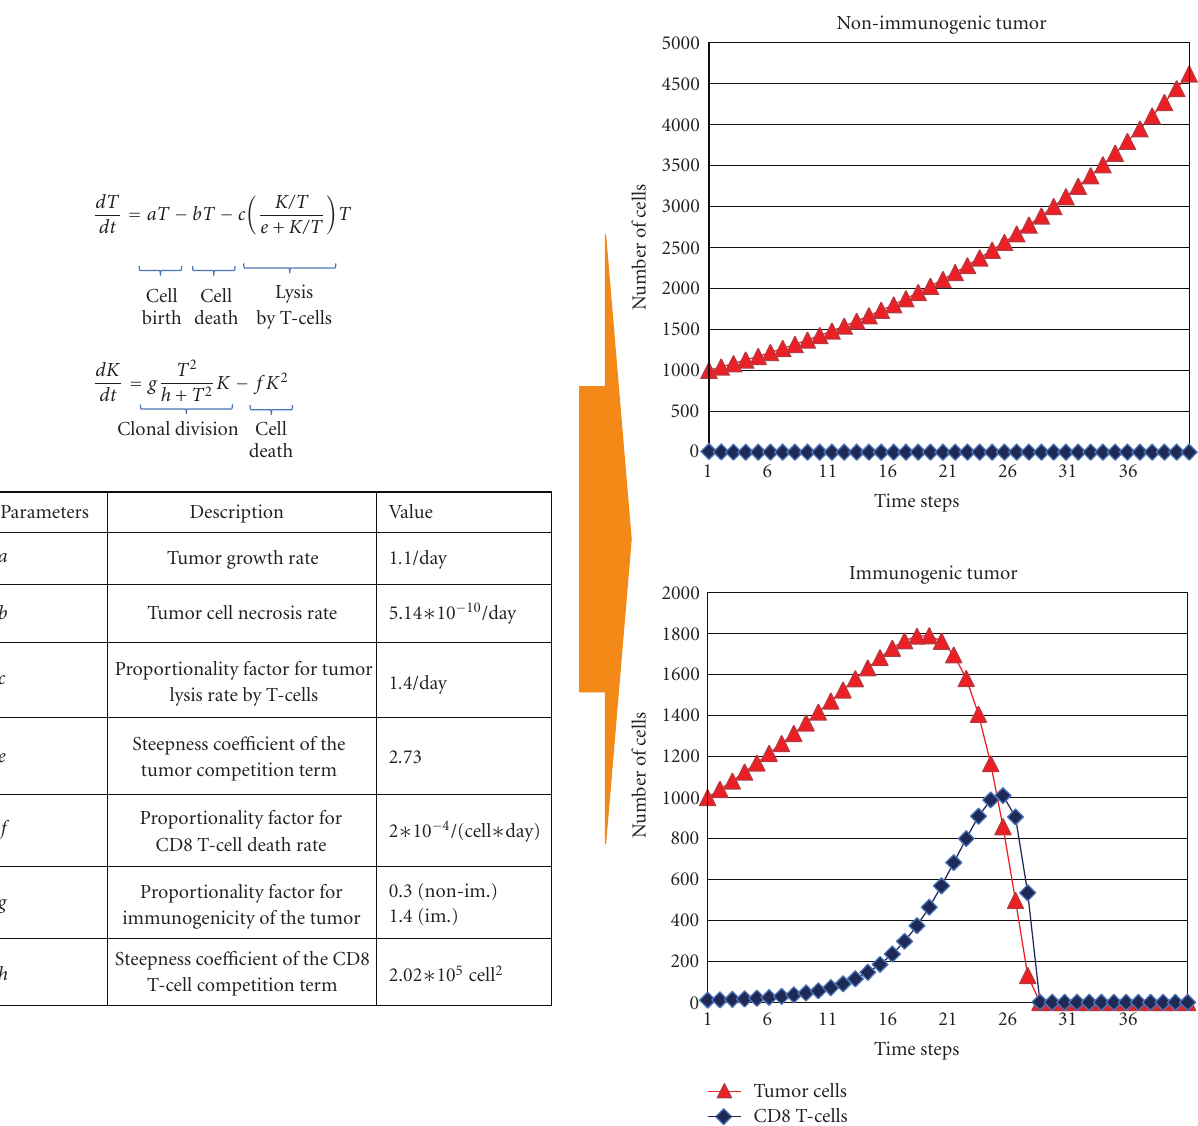
Figure 2: Di ff erential equations system. A simplified di ff erential equations system describes the interaction between tumor cells ( T ) and CD8 T-cells ( K ). The only di ff erence between the simulation of a nonimmunogenic tumor (upper graph) and an immunogenic tumor (lower graph) is that parameter g is increased leading to an increase in tumor immunogenicity. Lysis of tumor cells by the CD8 T-cells and the activation of CD8 T-cells by tumor cells follow a Michaelis-Menten kinetic to account for saturation at high cell numbers. The death rate of CD8 T-cells is proportional to the square of the cell number to assure for fast declining waves of T-cell expansion. Equations and parameters modified from [27], parameters originally obtained from a published mouse study